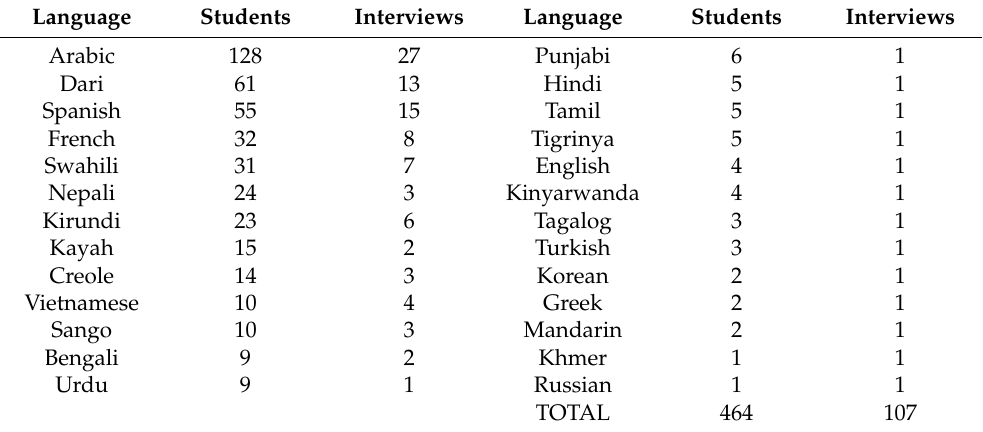
Table 1. Number of students and number of group interviews for the main data collection, by language of